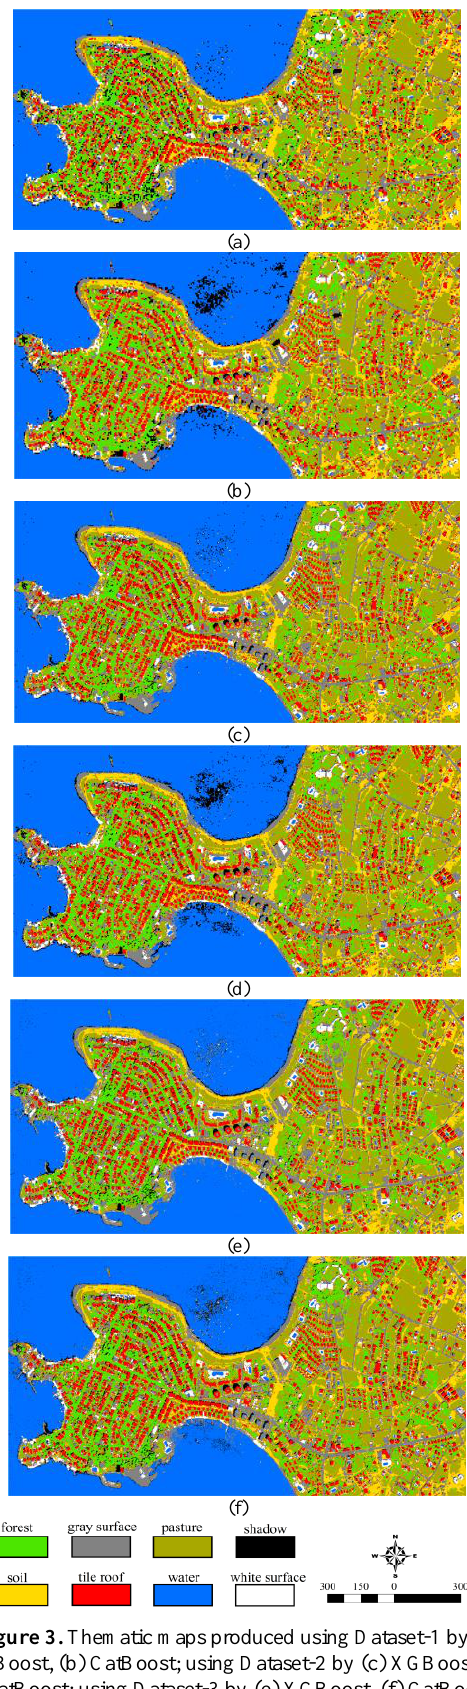
Figure 3. Thematic maps produced using Dataset-1 by (a) XGBoost, (b) CatBoost; using Dataset-2 by (c) XGBoost, (d) CatBoost; using Dataset-3 by (e) XGBoost, (f)